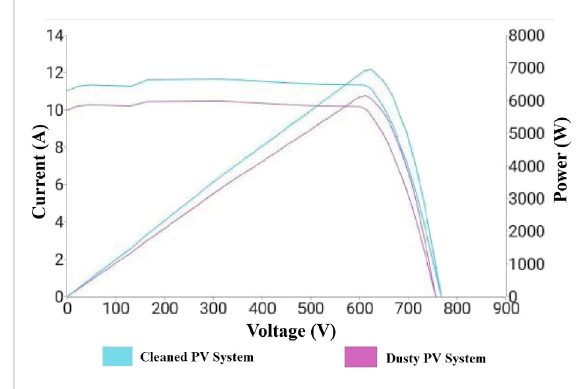
FIGURE 13 I – V curve of cleaned and dusty PV systems to compare system performance in